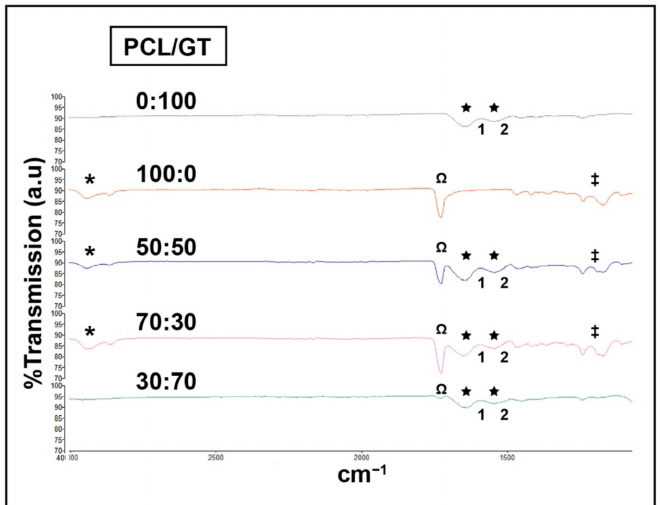
Figure 4. FTIR spectra of PCL/GT nanofibers. Blended composite PCL and GT contained both polymer’s spectrum as indicated by the distinctive peaks. * H-C-H stretching, Ω carbonyl (C=O) stretching, ‡ C-O-C stretching indicates PCL presence. (cid:70) Common bands of protein (indicates the presence of GT); 1 . C-O stretching, 2 . N-H and C-N (peptide bond)